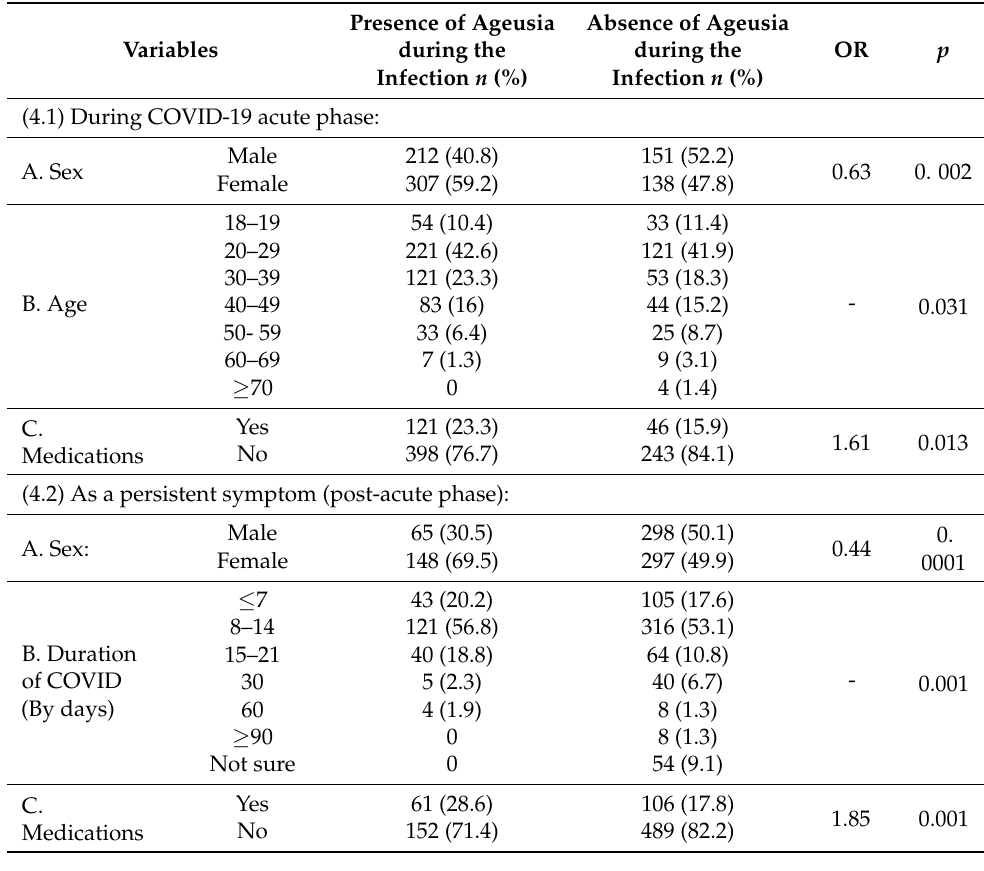
Table 4. Characteristics of the participants in association with experiencing